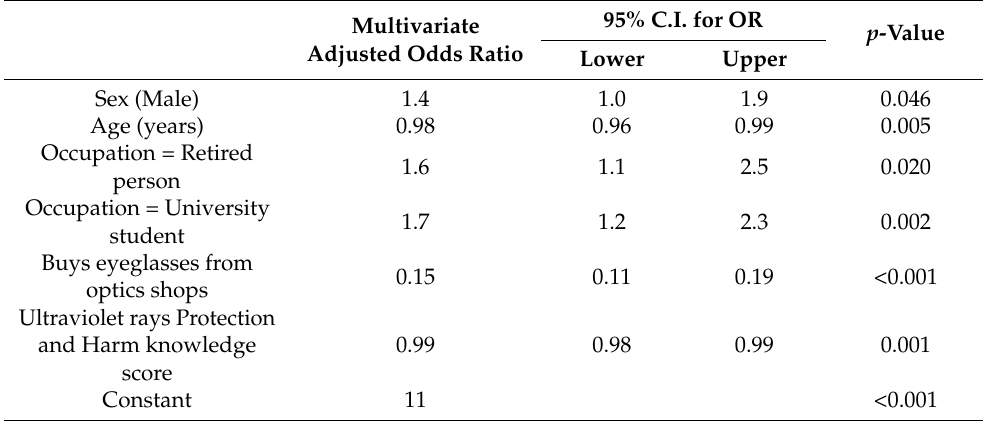
Table 5. Multivariate Logistic Regression Analysis of not using UV-protective